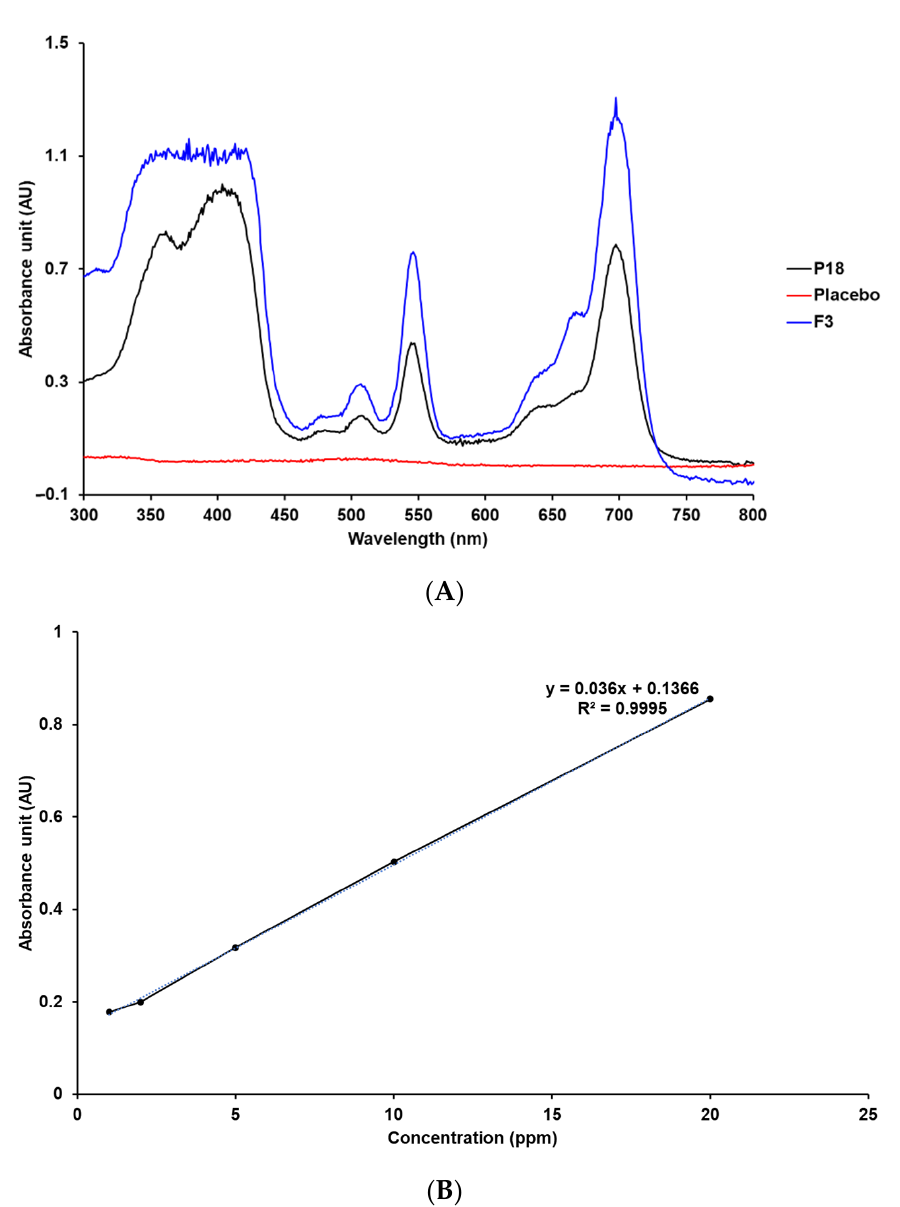
Figure 2. UV-Vis spectra and calibration curve of P18. ( A ) Specificity data of P18, placebo, and P18-loaded SLN F3 (MeOH, 25 °C). ( B ) Linearity data of P18 standard stock solution in MeOH. Table 2. Precision data obtained from the developed analytical method for P18.